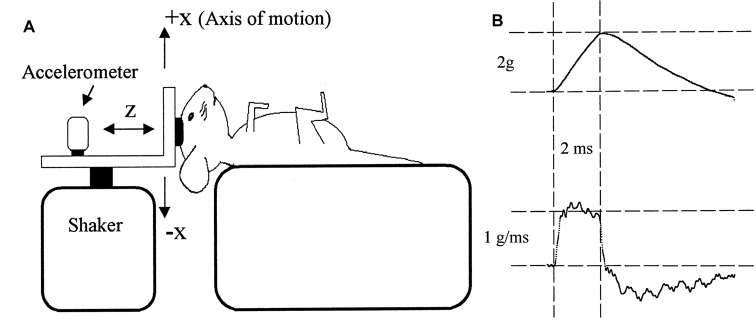
(A) The typical experimental setup used to evoke VsEP responses in animals. An electrodynamic modal shaker is attached to the animal’s skull via a screw or clamp. The acceleration is measured on the modal shaker connector. (B) Acceleration pulses rise gradually over 2 ms, producing a monophasic 2 ms jerk of the head. Reproduced with permission from Jones and Jones (1999).